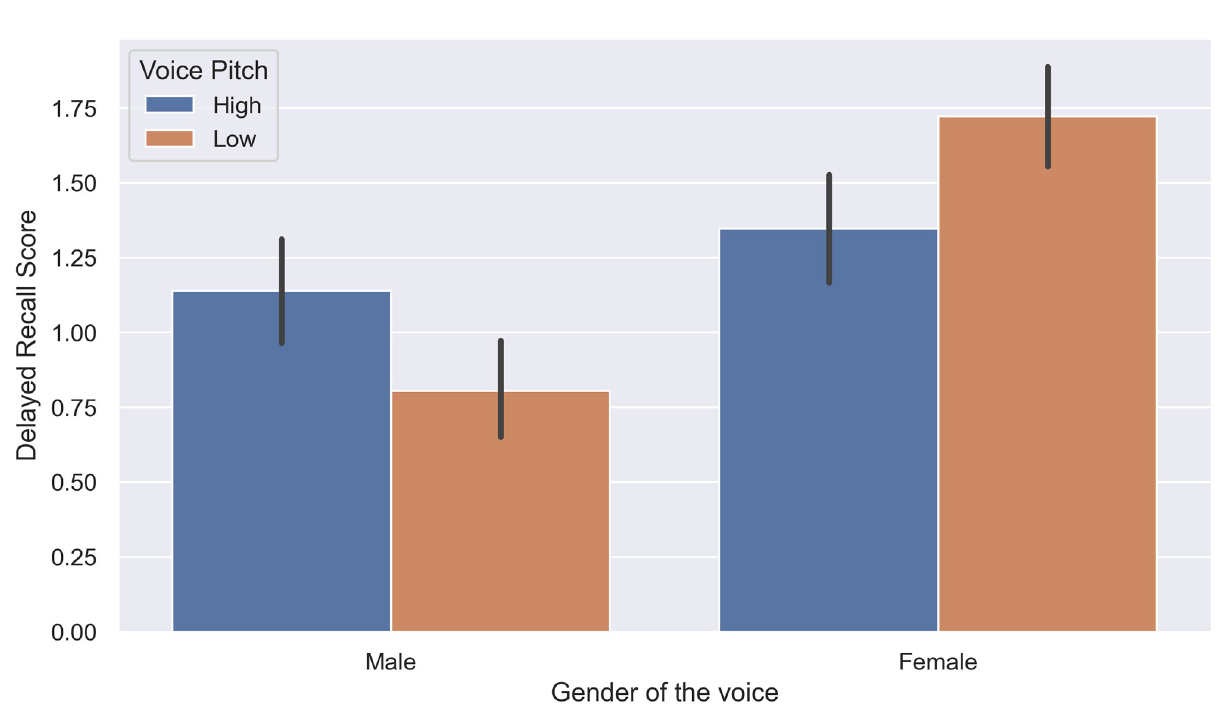
Fig 3. Interaction of voice gender and voice pitch in the delayed recall task (Experiment 1).